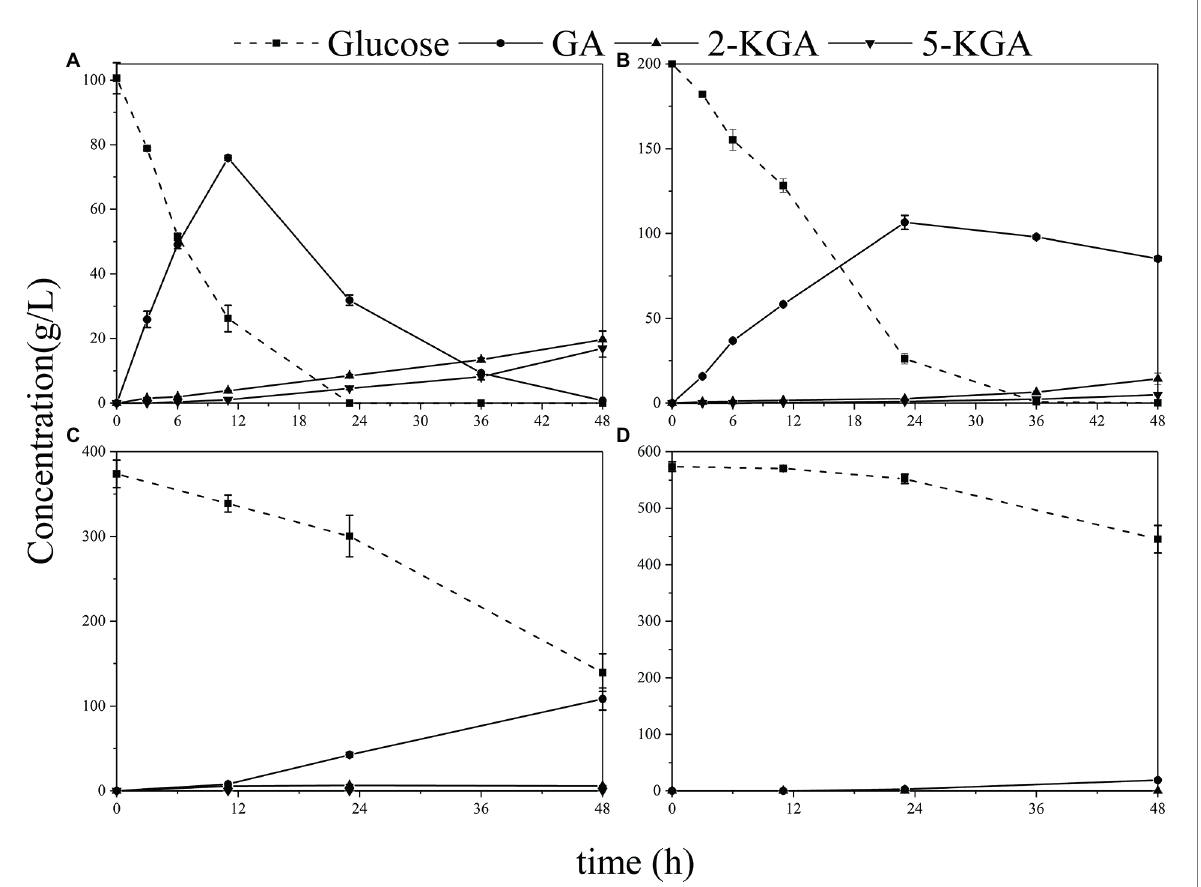
FIGURE 3 The production of GA, 2-KGA and 5-KGA in various glucose titers. (A) Initial 100 g/L glucose; (B) initial 200 g/L glucose; (C) initial 400 g/L glucose; (D) initial 600 g/L